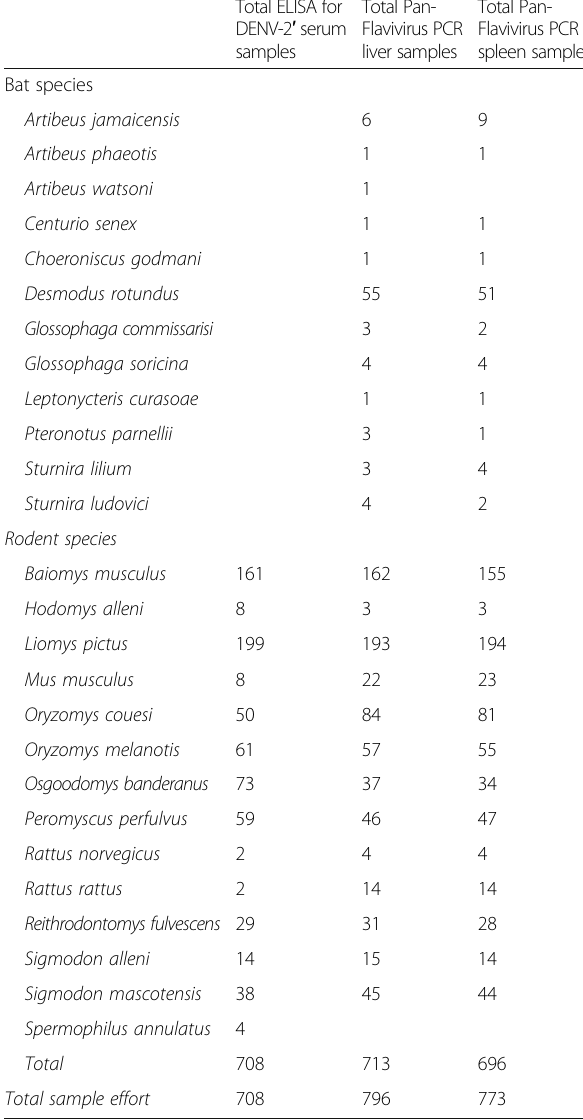
Table 1 Bat and rodent species, and the number of serum, liver, and spleen samples tested Total ELISA for DENV-2 ′ serum